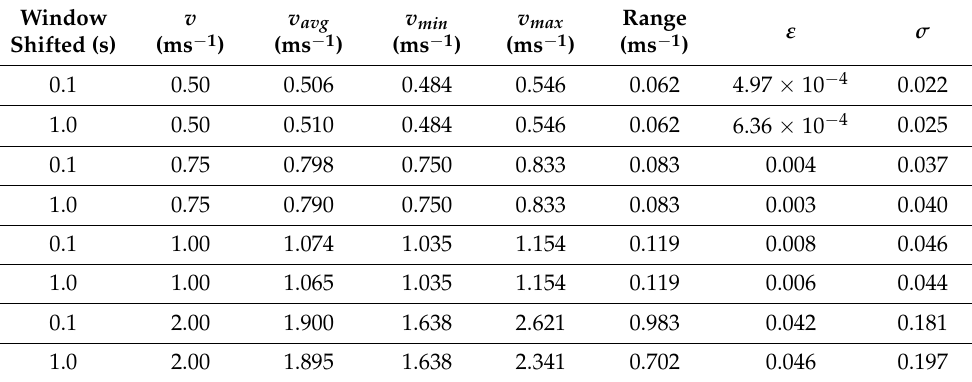
Table 3. Qualitative indicators obtained for four velocity values ( v ) and measurement window with length 1 s, shifted 0.1 s and 1